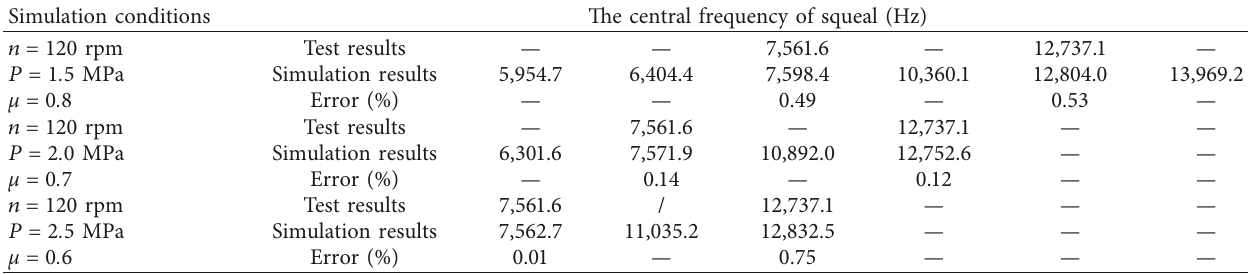
Table 3: Comparison between the results of complex eigenvalue analysis and the bench test of brake squeal. Simulation conditions